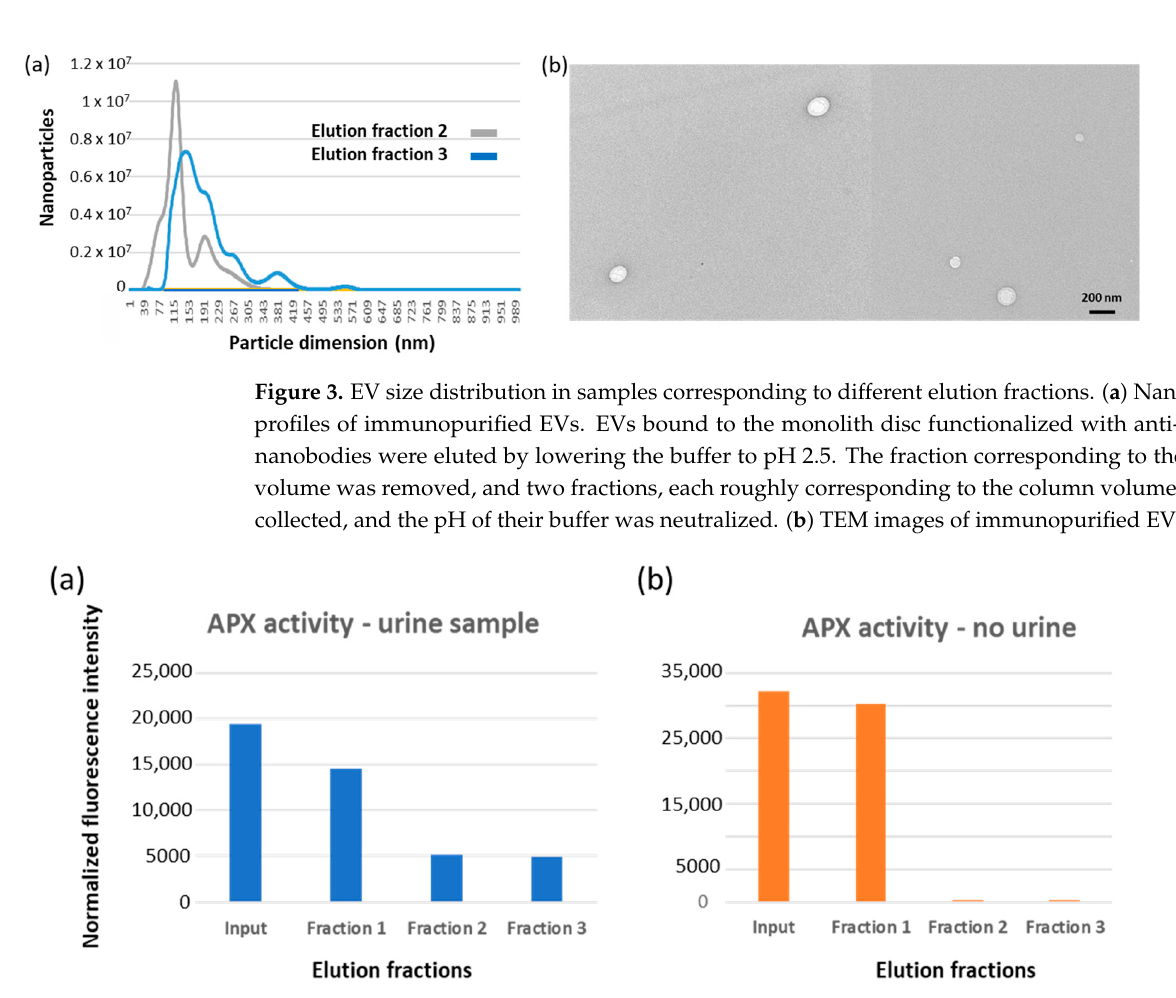
Figure 4. APX peroxidase activity in EV elution fraction . ( a ) The solution containing APX ‐ anti ‐ CD63 (input) was loaded onto a functionalized filter coated with EVs and recovered downstream (fraction 1). After extensive washing, EVs were eluted in 2–3 fractions by addition of acidic buffer. The enzymatic activity of each fraction was estimated by measuring the enzyme substrate conversion into a fluorescent component. ( b ) As a negative control to assess any direct binding of APX ‐ anti ‐ CD63 to the filter, the same experiment was performed in the absence of a urine sample.